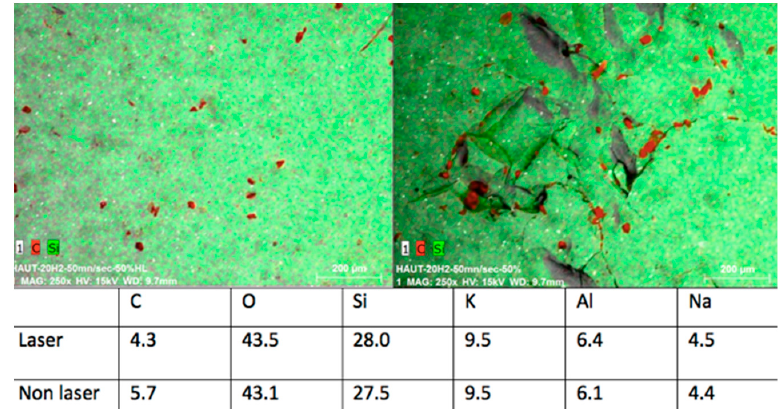
Figure 10. ( Left ) Control group and ( right ) samples irradiated with peak power of 5 kW and a speed of 50 mm/s: the C concentration is shown in red.